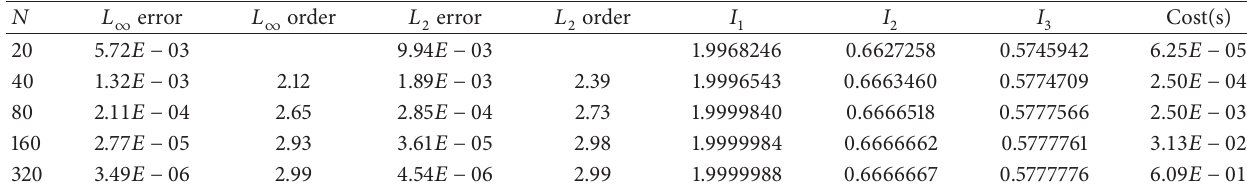
Table 1: Numerical errors and orders of CIP-HOC method for the KdV equation (29).